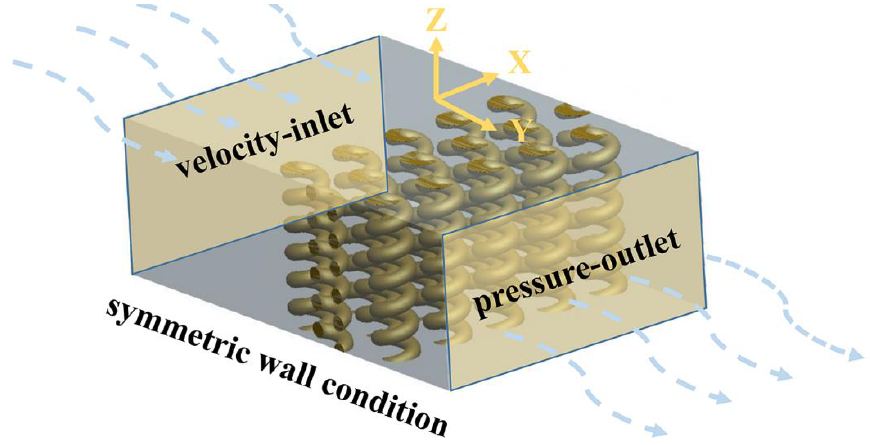
Figure 2. Simulation model of three-layer fibers.